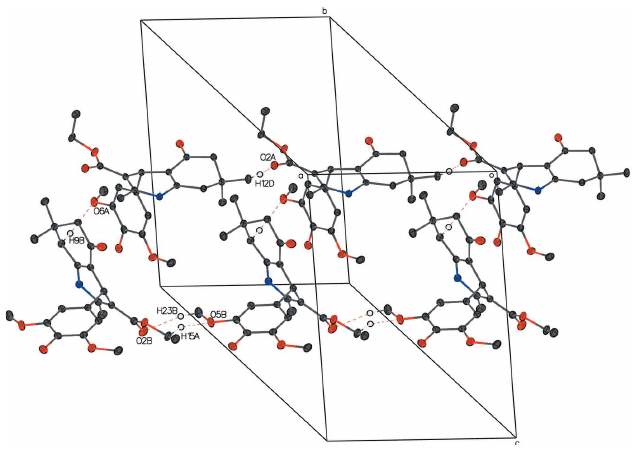
Figure 8 The packing of compound II showing the chains formed by A and B molecules along the a axis. For clarity, H atoms not participating in hydrogen bonds are omitted, and participating atoms are labeled once.